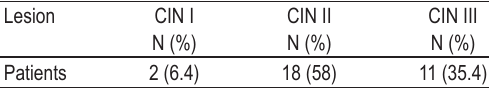
Table 3. Results of histology ‑ Subgroup